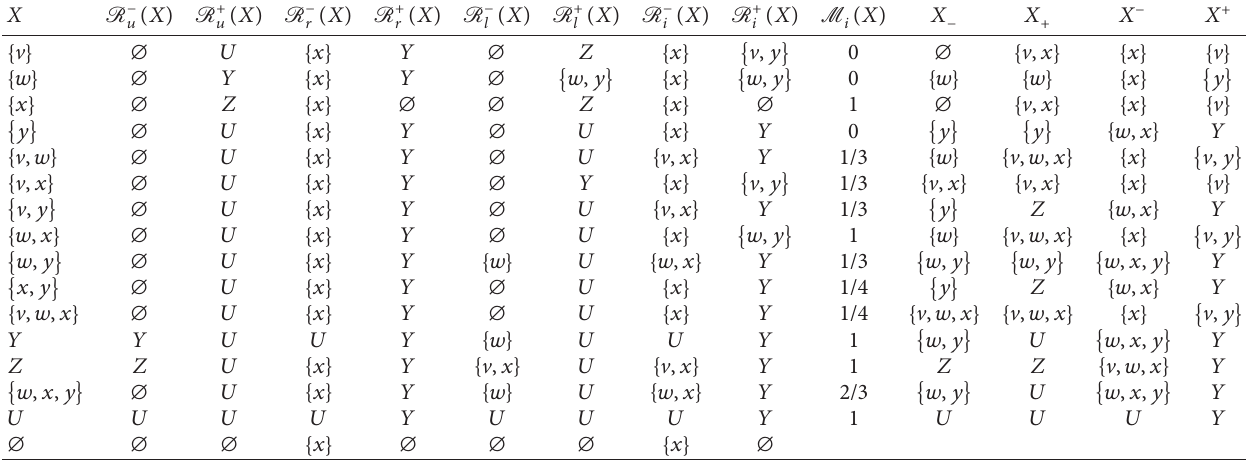
R j -upper approximations (